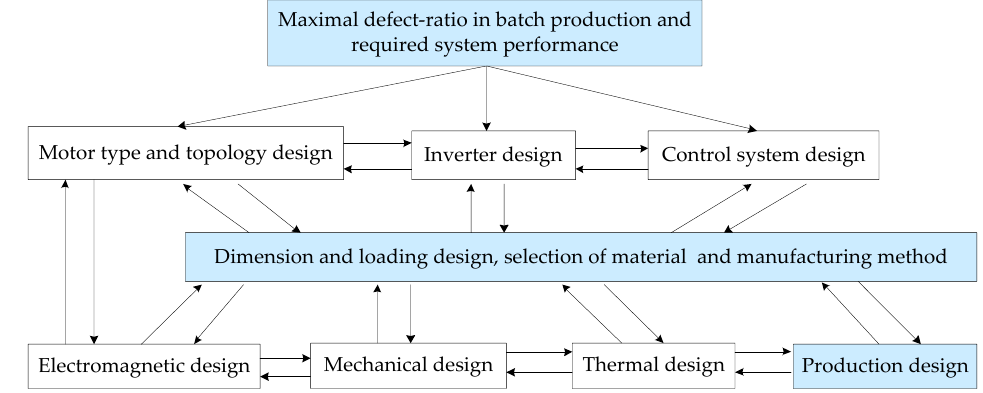
Figure 16. Framework of robust design of electrical drive systems for